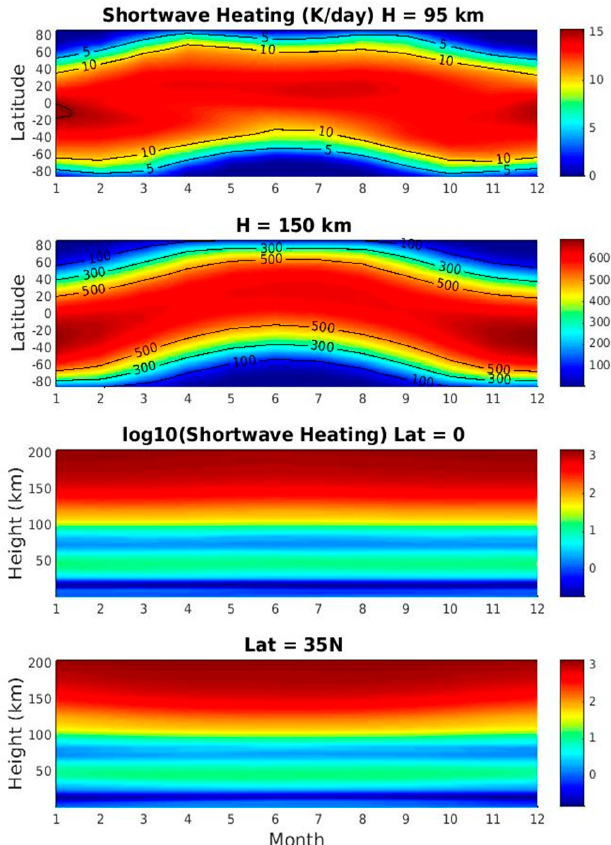
Figure 4. Top two panels: Seasonal variations of the short-wave heating (K/day) on the right-hand-side ( RHS ) of thermodynamic budget Equation (1) for DW1 at 95 and 150 km. Bottom two panels: seasonal variations of the short-wave heating as a function of height at the Equator and 35° N.